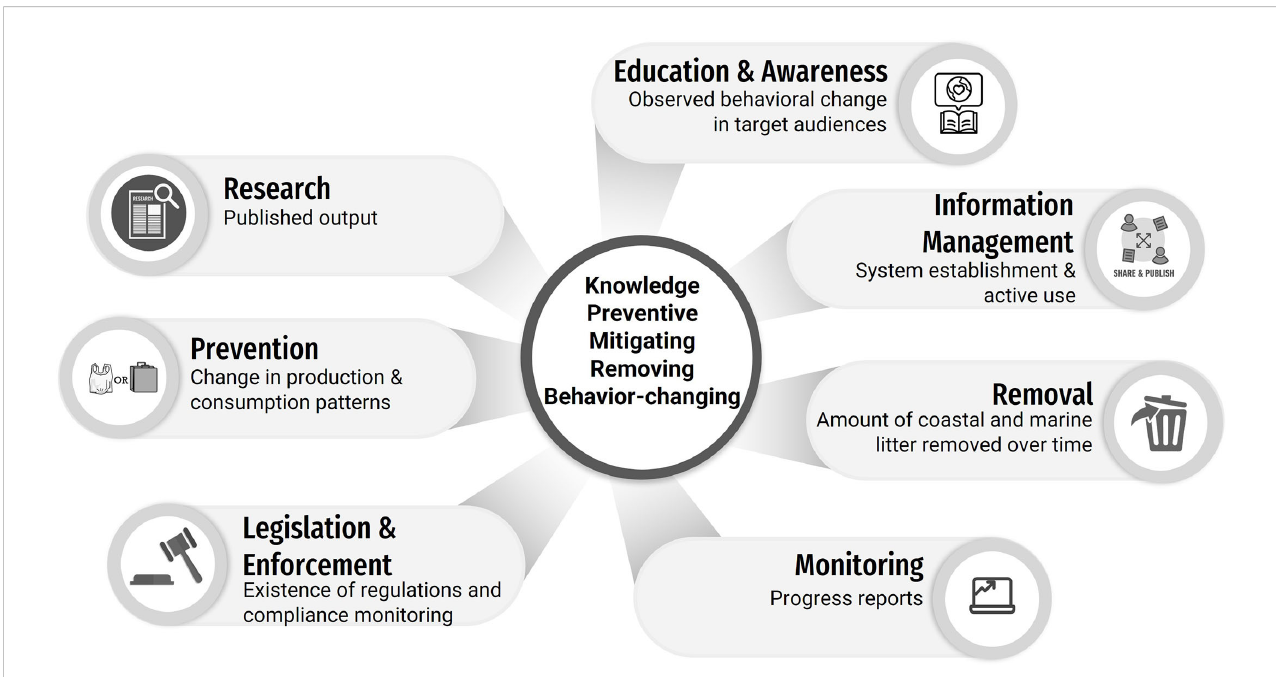
FIGURE 11 The categorization of marine debris management measures by Graham (2022a) with proposed indicators. Management activities containing indicators are more useful for formulation, implementation and evaluation of action